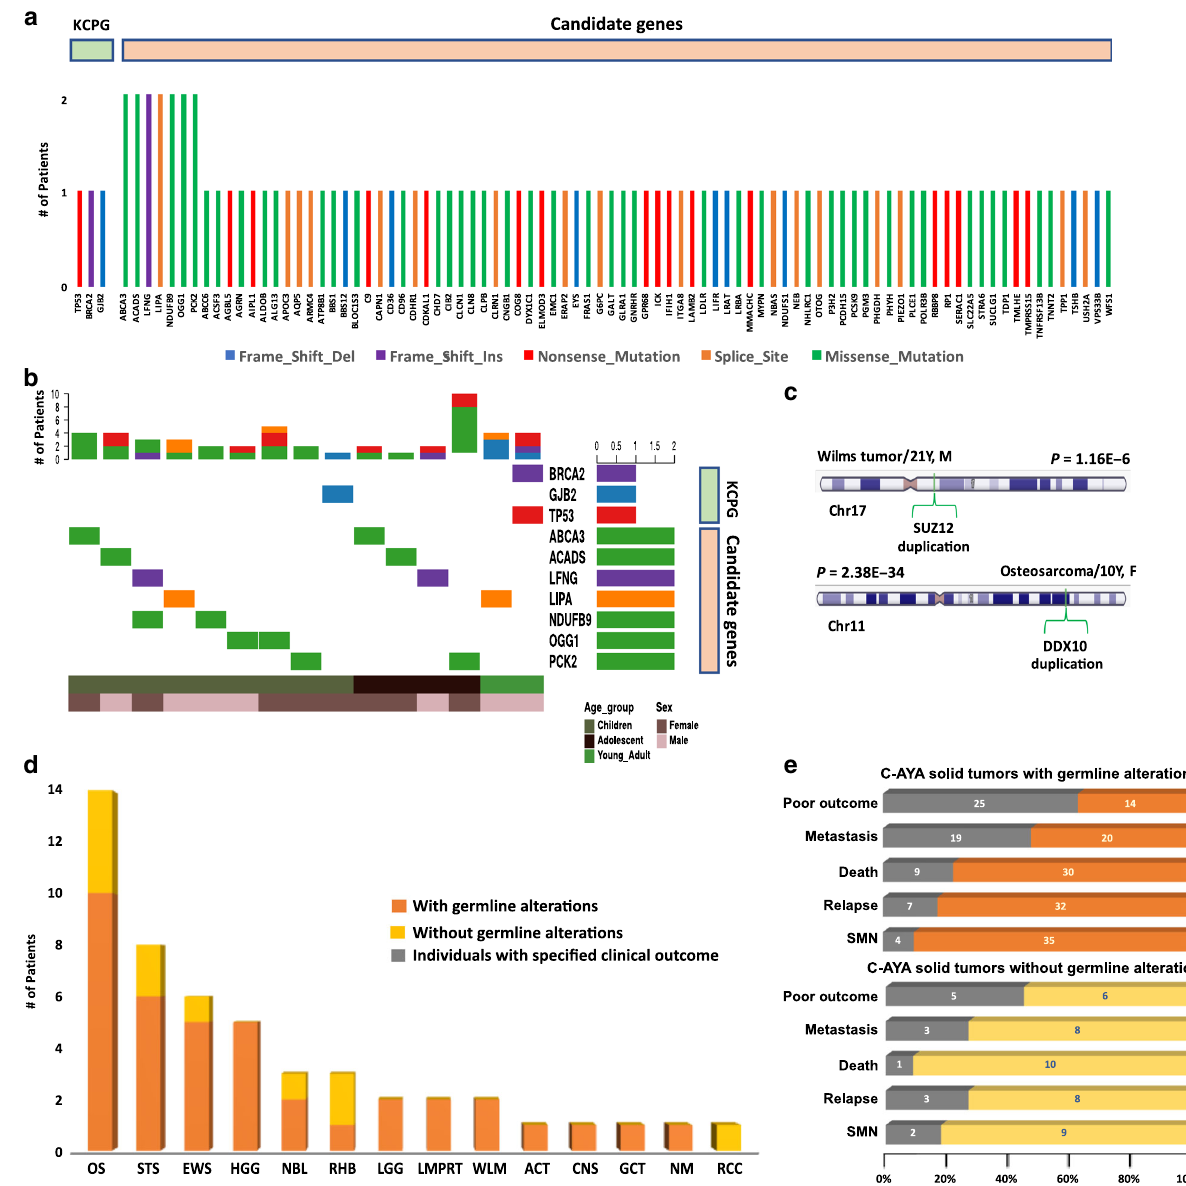
Fig. 1 Germline alterations and clinical outcomes in the Cleveland Clinic series. a Genes with germline pathogenic/likely pathogenic (P/LP) variants in known cancer-predisposing genes (KCPG) and candidate genes and their type of alterations in children, adolescents, and young adult (C-AYA) patients with solid tumors. b Oncoplots of top mutated genes with P/LP variants in KCPG and candidate genes based on the age group. Each column represents one patient and its affected genes. c Two examples of copy number variations (CNVs) found in C-AYA patients with solid tumors. d The number of patients with germline alterations, both single-nucleotide variations (SNVs) and CNVs, in each tumor type. e Clinical outcome comparison between two groups of C-AYA patients with solid tumors, with and without germline alterations. Gray color represents the number of patients with the speci fi ed clinical outcome in each group. Two-sided Fisher's exact test was implemented, P = 0.31, OR = 2.14, 95% CI = 0.6 – 8.0. ACT adrenocortical carcinoma, CNS central nervous system, EWS Ewing sarcoma, GCT germ cell tumor, HGG high-grade glioma, LGG low-grade glioma, LMPRT low malignancy potential renal tumor, NBL neuroblastoma, NM non-malignant tumor, OS osteosarcoma, RCC renal cell carcinoma, RHB rhabdomyosarcoma, STS soft tissue sarcoma, WLM Wilms tumor, Del deletion, Ins (75.5%) had at least one variant in a candidate gene (Fig. 1d). C- outcome which we operationally de fi ned as any relapse, metastasis, second primary malignant neoplasm (SMN), or death, compared to the group without germline alterations (Fig. 1e) ( P = 0.31, odds ratio (OR) = 2.14, 95% con fi dence interval (CI) = 0.6 – 8.0). To validate our fi ndings with a larger independent series, we